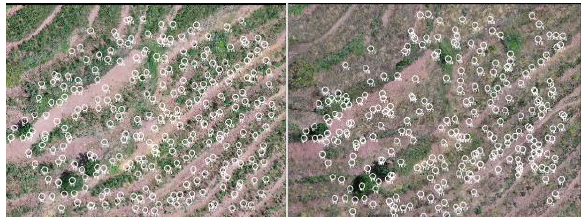
Figure 11 . Corresponding image points based on image matching